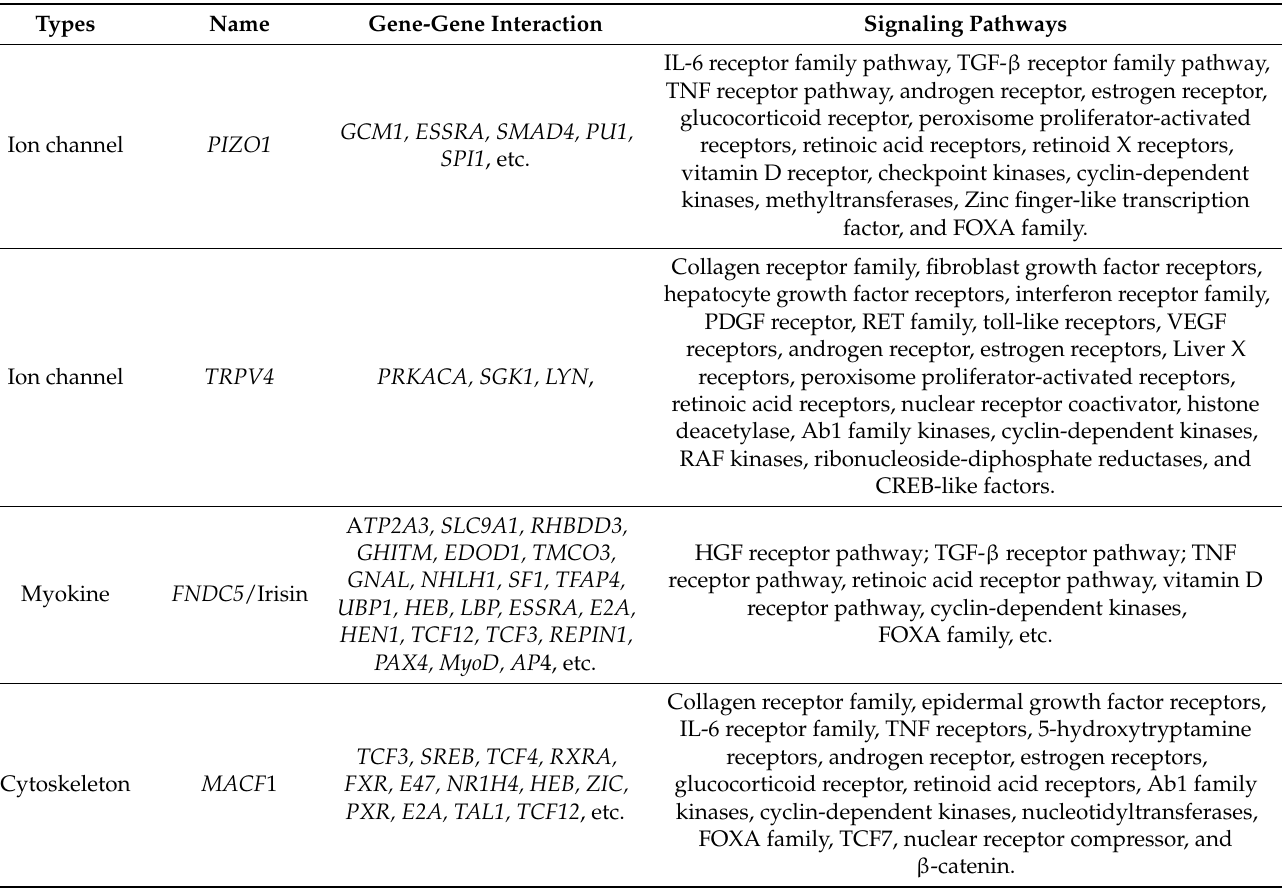
Table 2. Bioinformatics Cytoscape (http://cytoscaple.org (accessed on 27 July 2021)) and Genecards (www.genecards.org (accessed on 27 July 2021)) predication of mechanosensitive molecules involving gene-gene interaction and intracellular